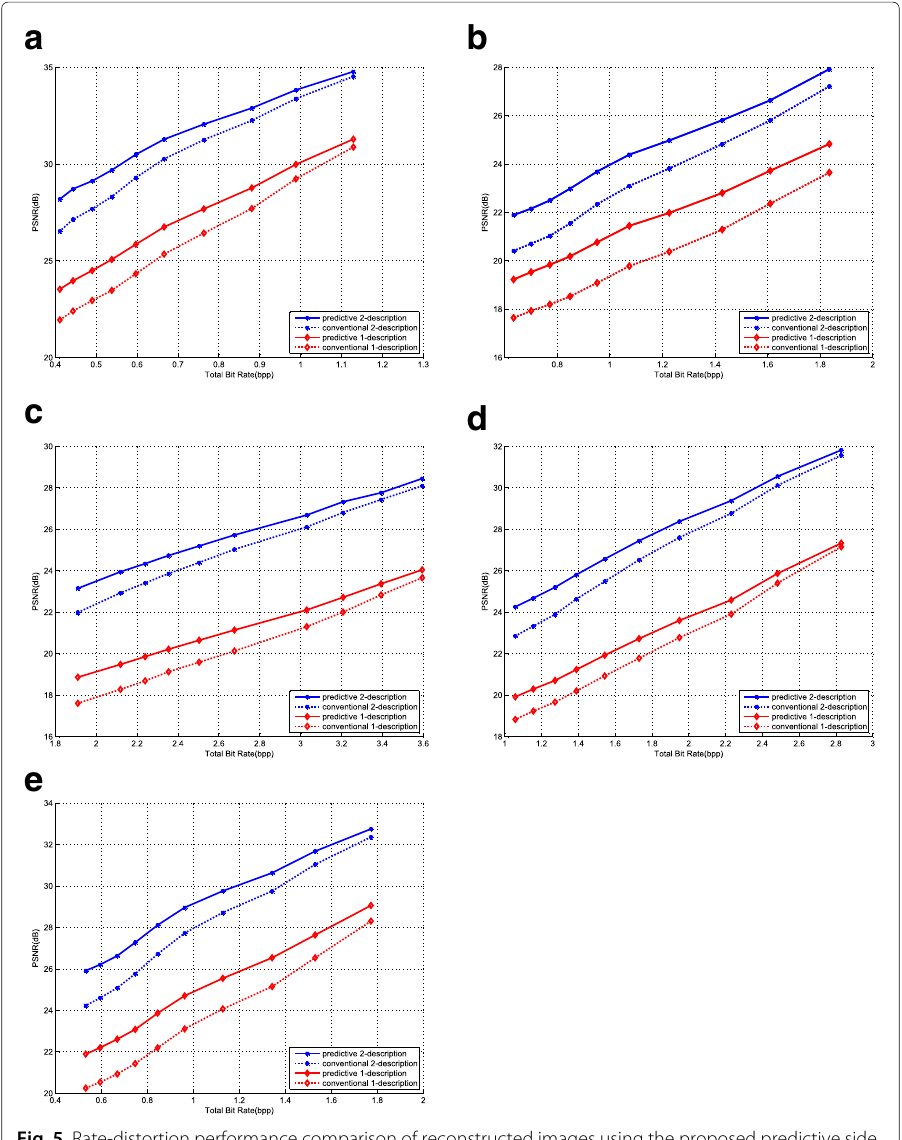
Fig. 5 Rate-distortion performance comparison of reconstructed images using the proposed predictive side decoding and the conventional side decoding: a “Lena,” b “Couple,” c “Baboon,” d “Aerial,” and e